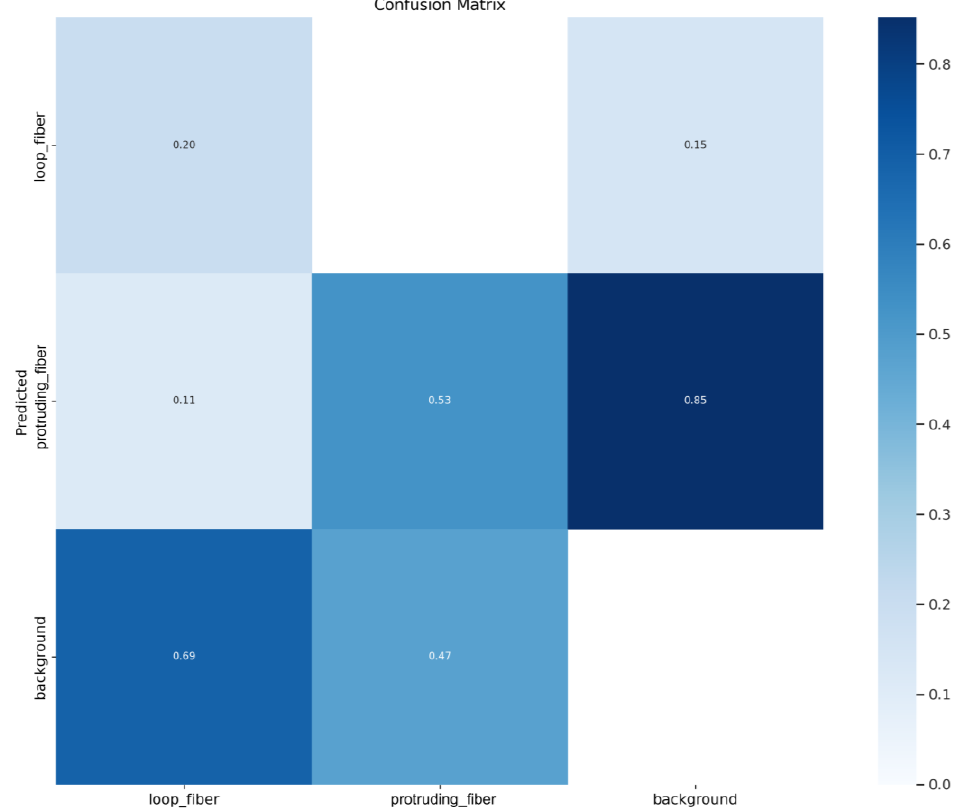
Figure 44. Obtained confusion matrix for this training setup.